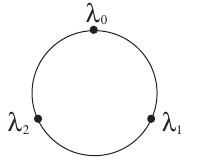
FIG. 2. The only possible permutation for D ¼ 3 . The solid lines between the eigenvalues represent the weighting of the